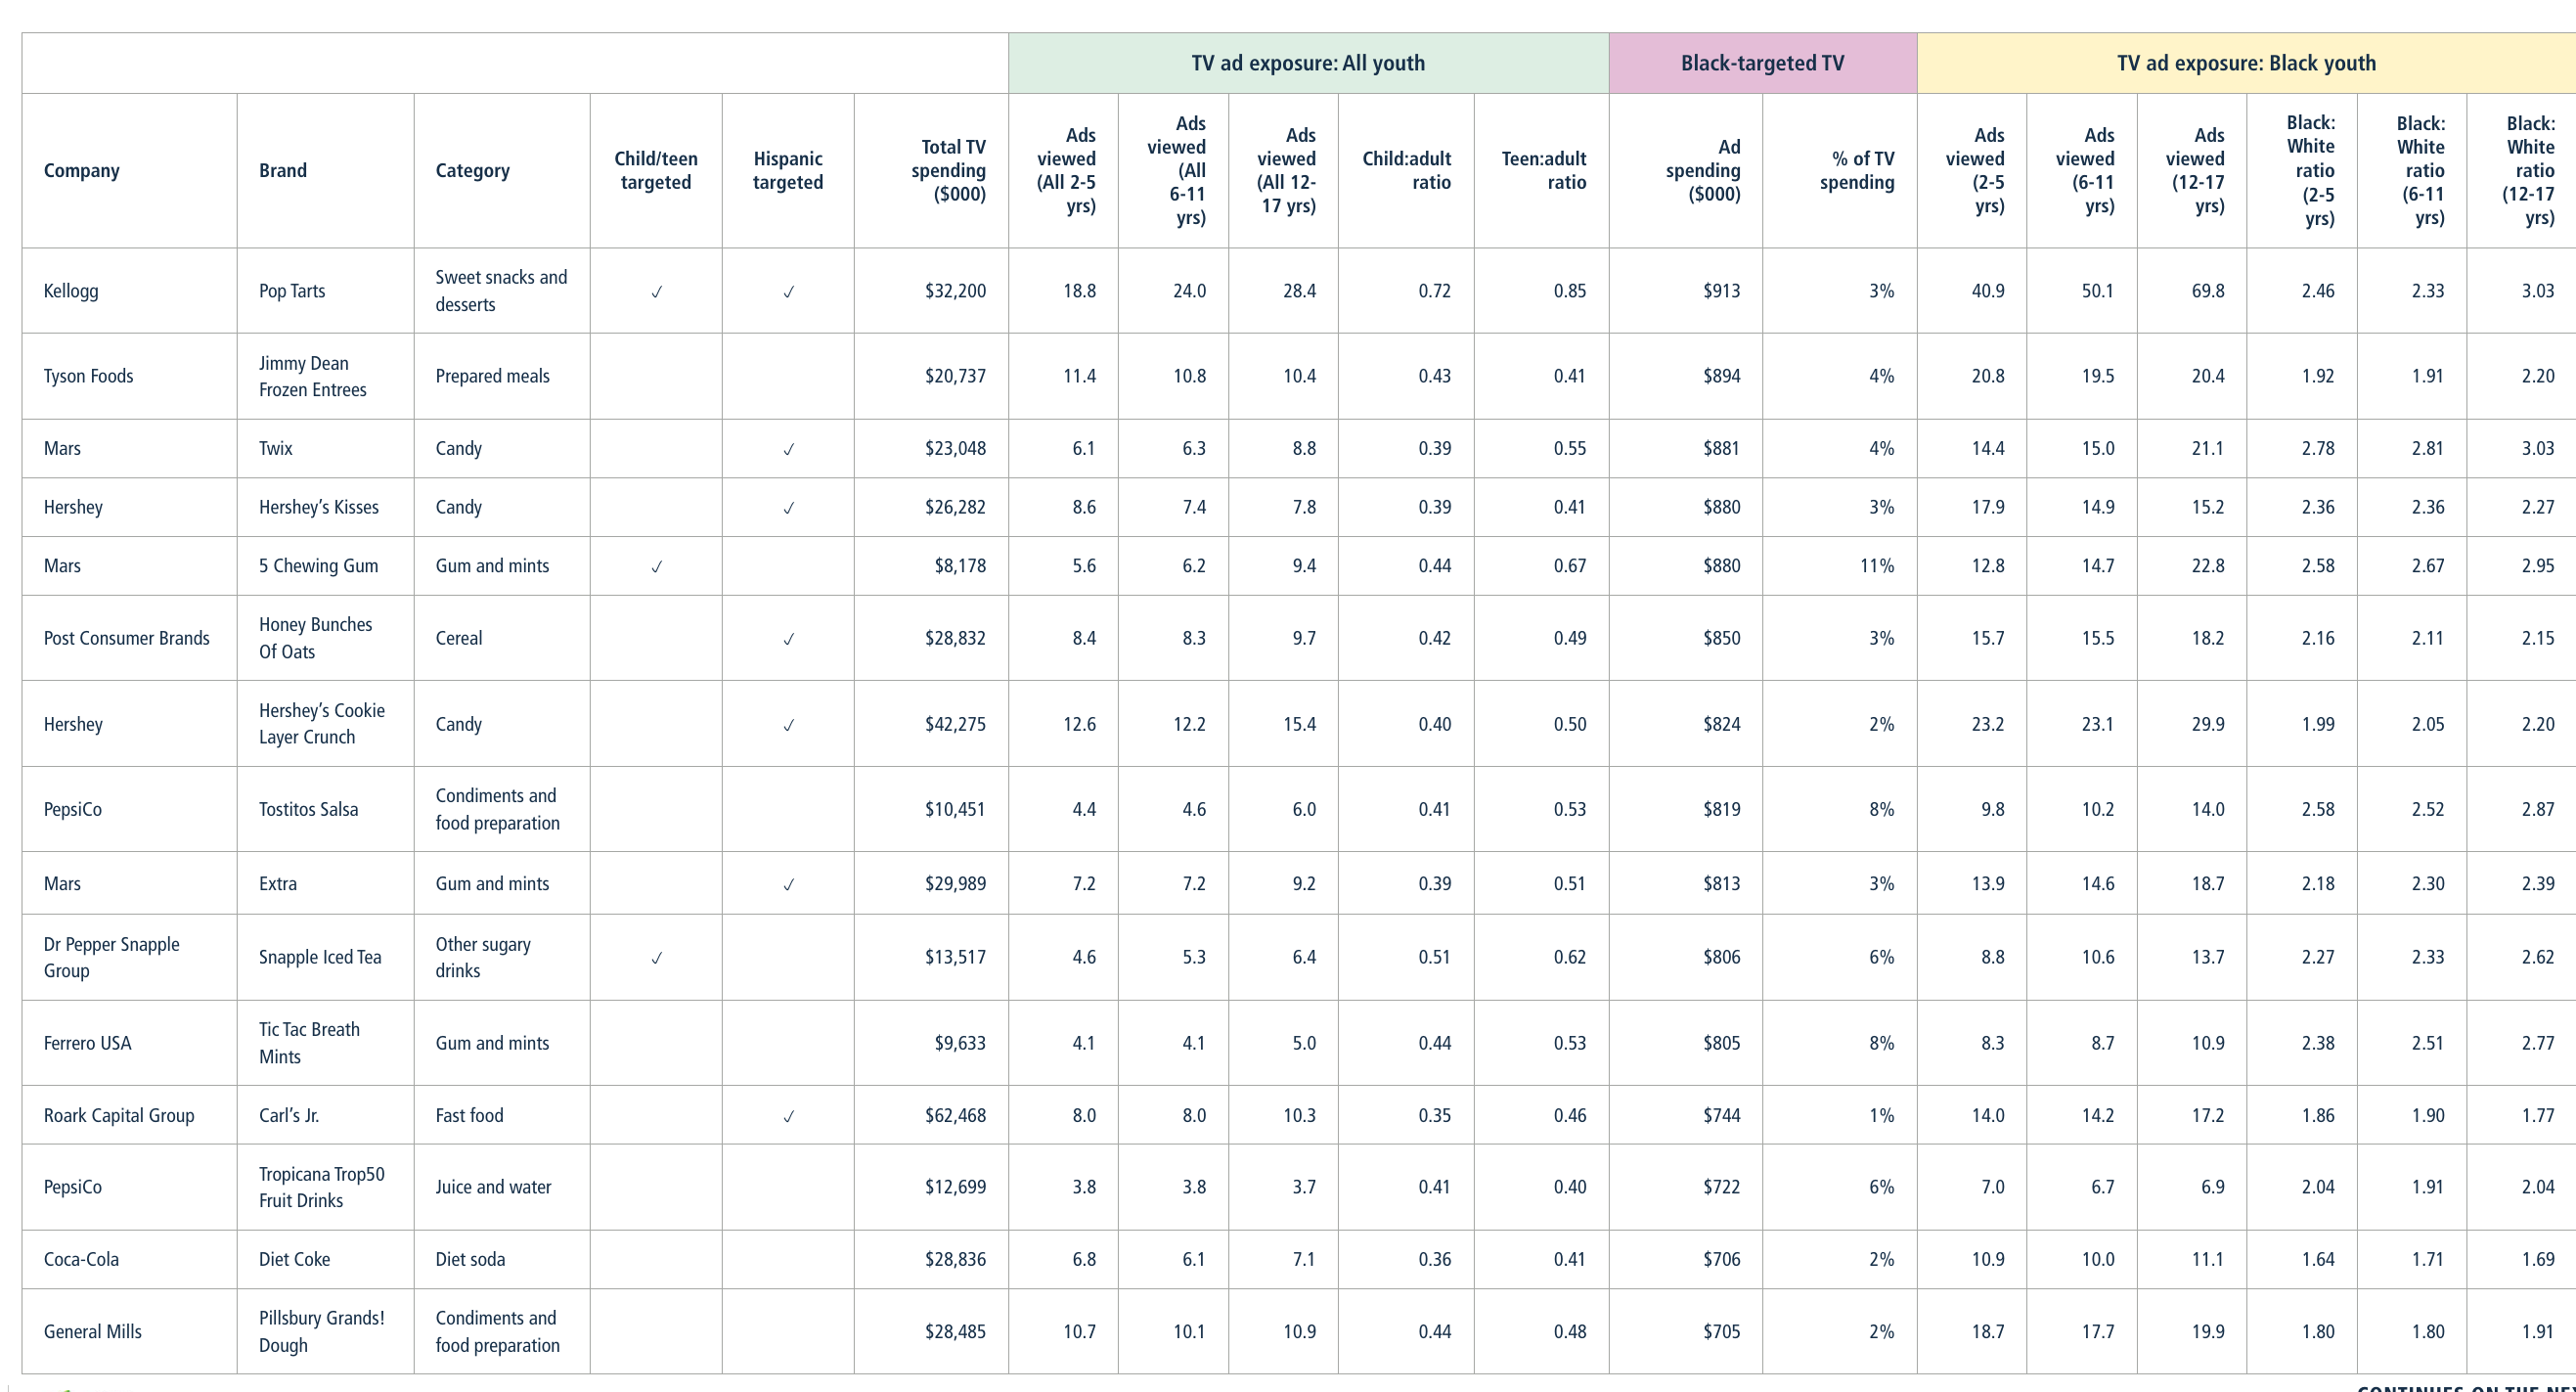
TABLE 3. BRANDS TARGETED TO BLACK CONSUMERS